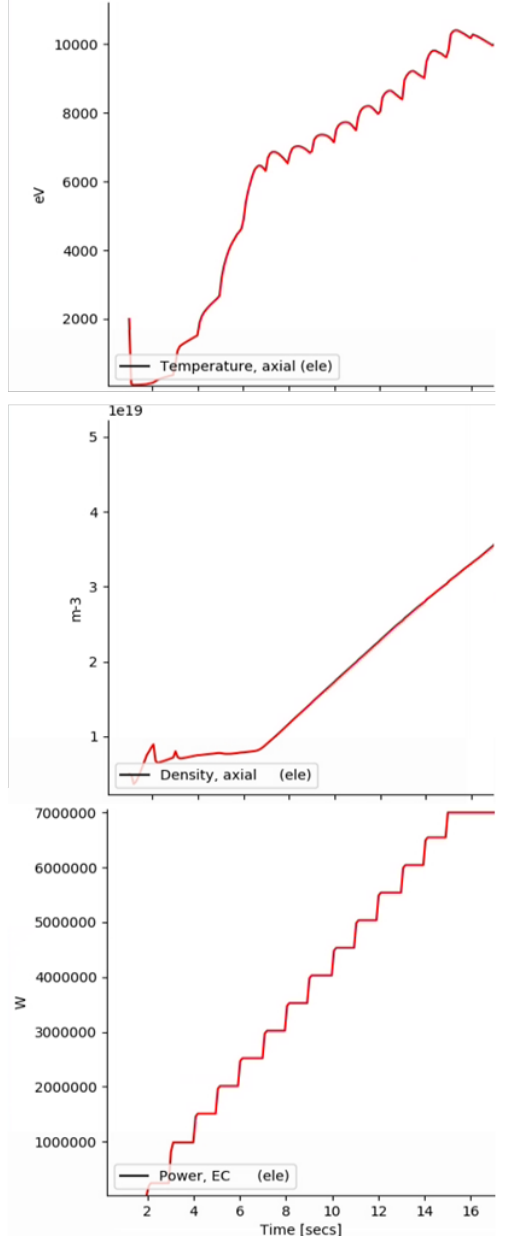
Fig. 2. Time evolution of the axial electron temperature (top), of the axial density (mid) and of the absorbed EC power (bottom) for case 1 simulation in Table 1.